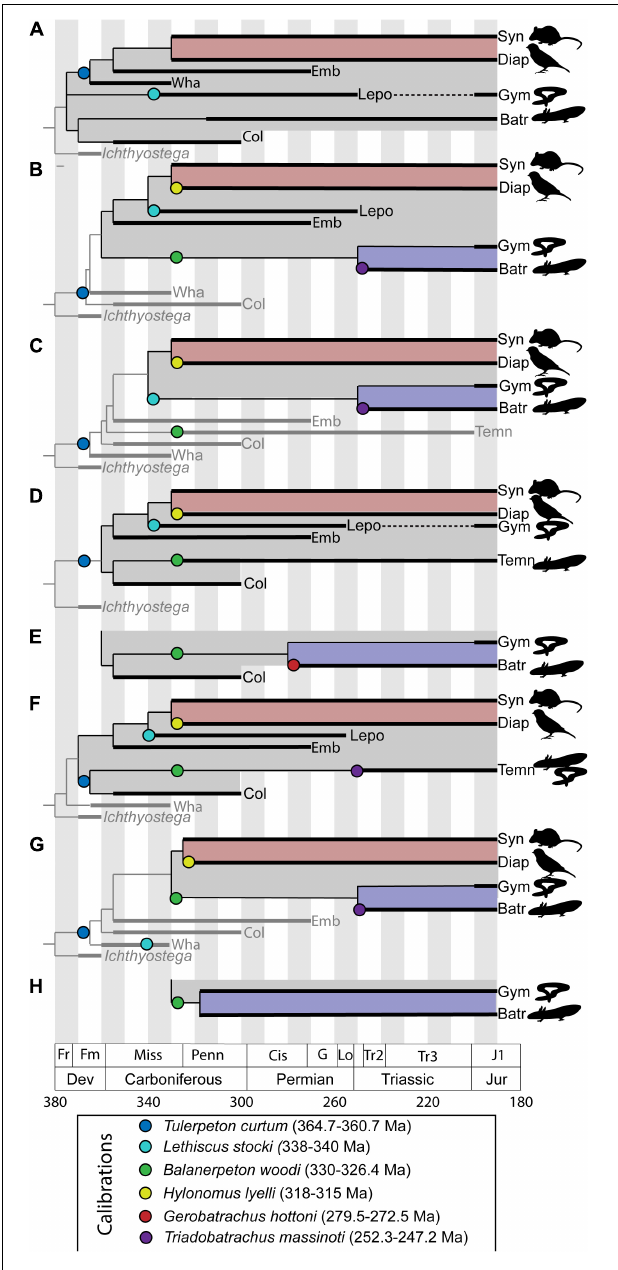
FIGURE 1 | Comparative phylogenetic hypotheses of early tetrapod interrelationships and lissamphibian affinities, showing effects on node calibrations for the age of tetrapod (gray) and lissamphibian crown (blue). (A) Modified from Carroll (2001); (B) modified from Ruta and Coates (2007); (C) modified from Vallin and Laurin (2004); (D) modified from Anderson et al. (2008); (E) variant of (D) modified from Maddin et al. (2012); (F) modified from Clack et al. (2017); (G) modified from Pardo et al. (2017a); (H) variant of (G) modified from Pardo et al. (2017b). Taxonomic abbreviations: Batr, Batrachia; Col, Colosteida; Diap, Diapsida; Emb, Embolomeri; Gym, Gymnophiona; Lepo, Lepospondyli; Syn, Synapsida; Temn, Temnospondyli; Wha, Whatcheeriida. Gray boxes delineate the tetrapod crown, red boxes delineate the amniote crown, and blue boxes delineate the lissamphibian crown (where present). Phylogenetic position of taxa often used to calibrate node ages denoted with colored